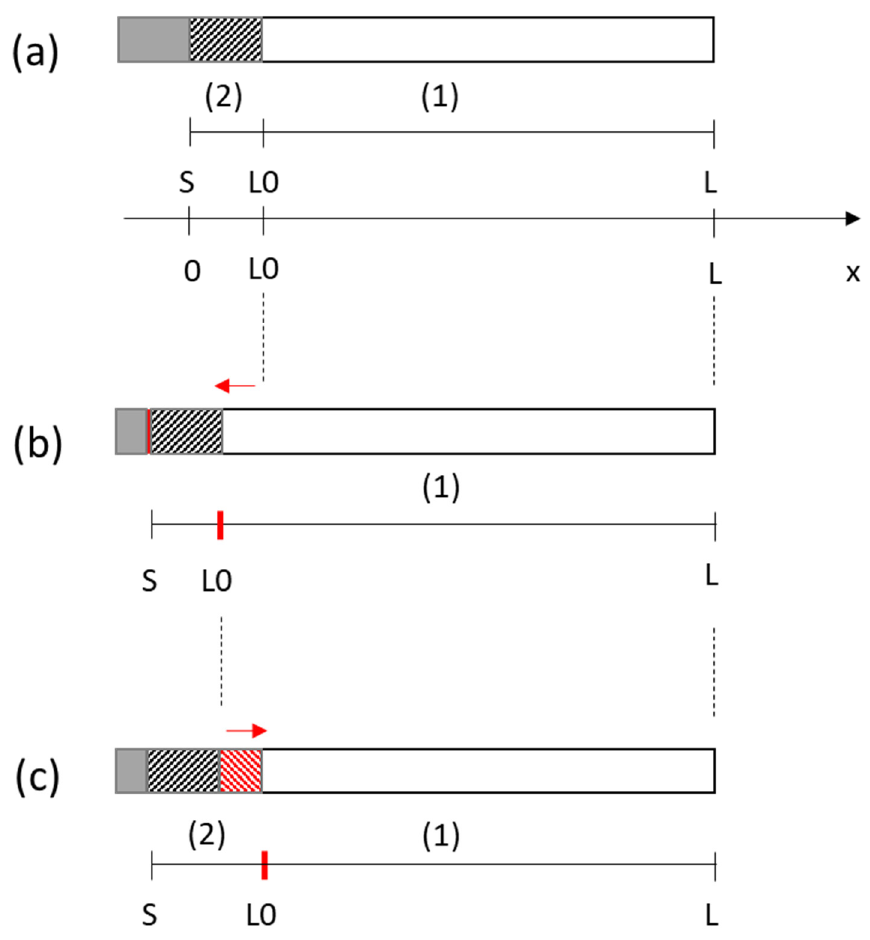
Figure 3. Schematic representation of the movement of the CPL corrosion product layer (domain (2)) of size x = L0. ( a ) At t0, ( b ) evolution during dissolution of the lead electrode and ( c ) precipitation of PbCl 2 .